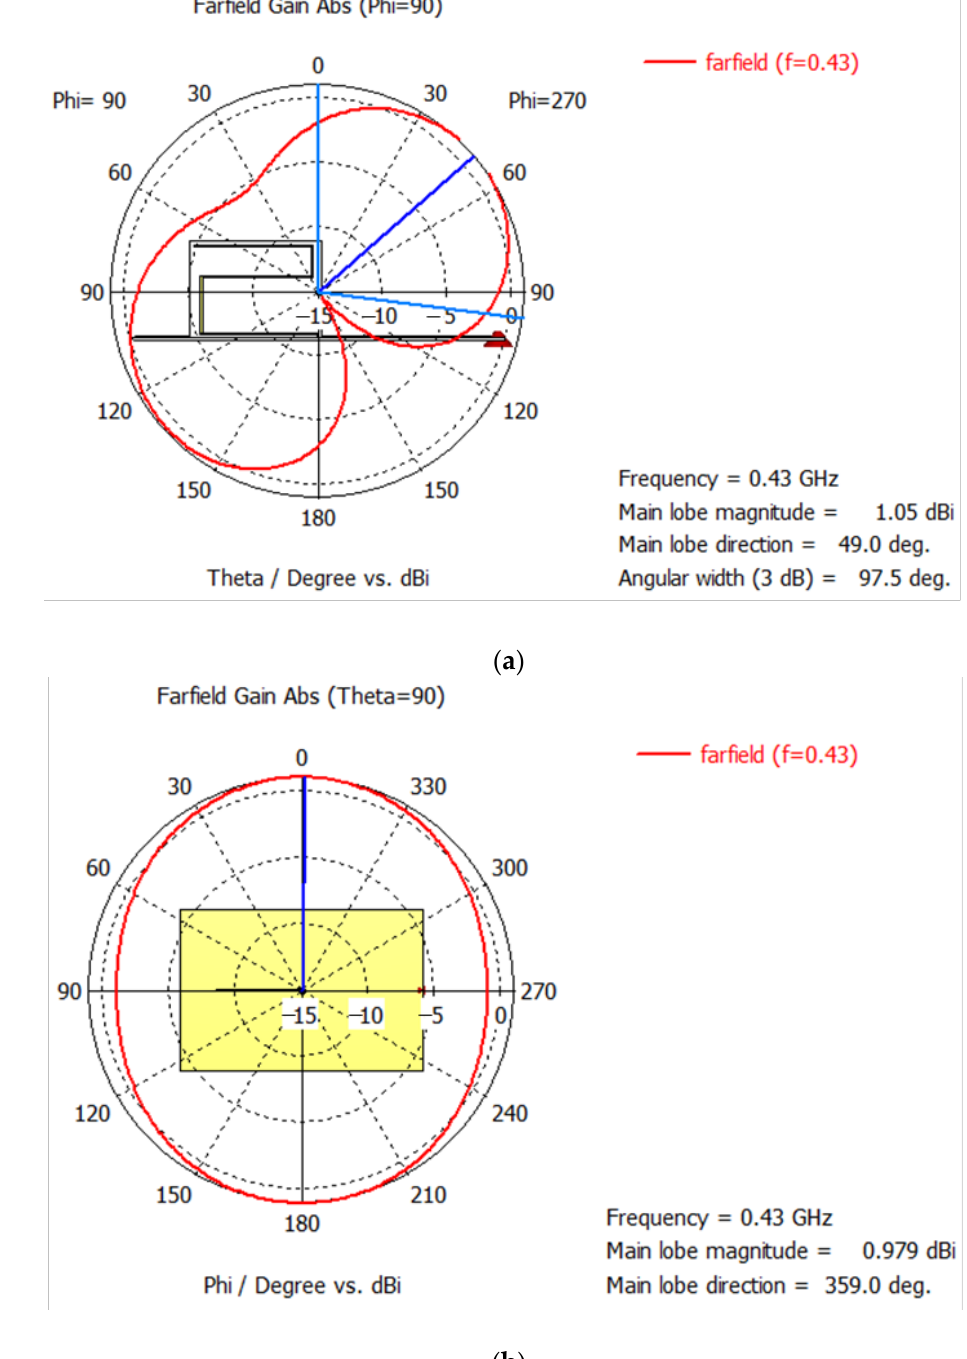
Figure 17. Radiation pattern of the printed meander line monopole antenna with an input impedance matching circuit: ( a ) E plane; ( b ) H plane.